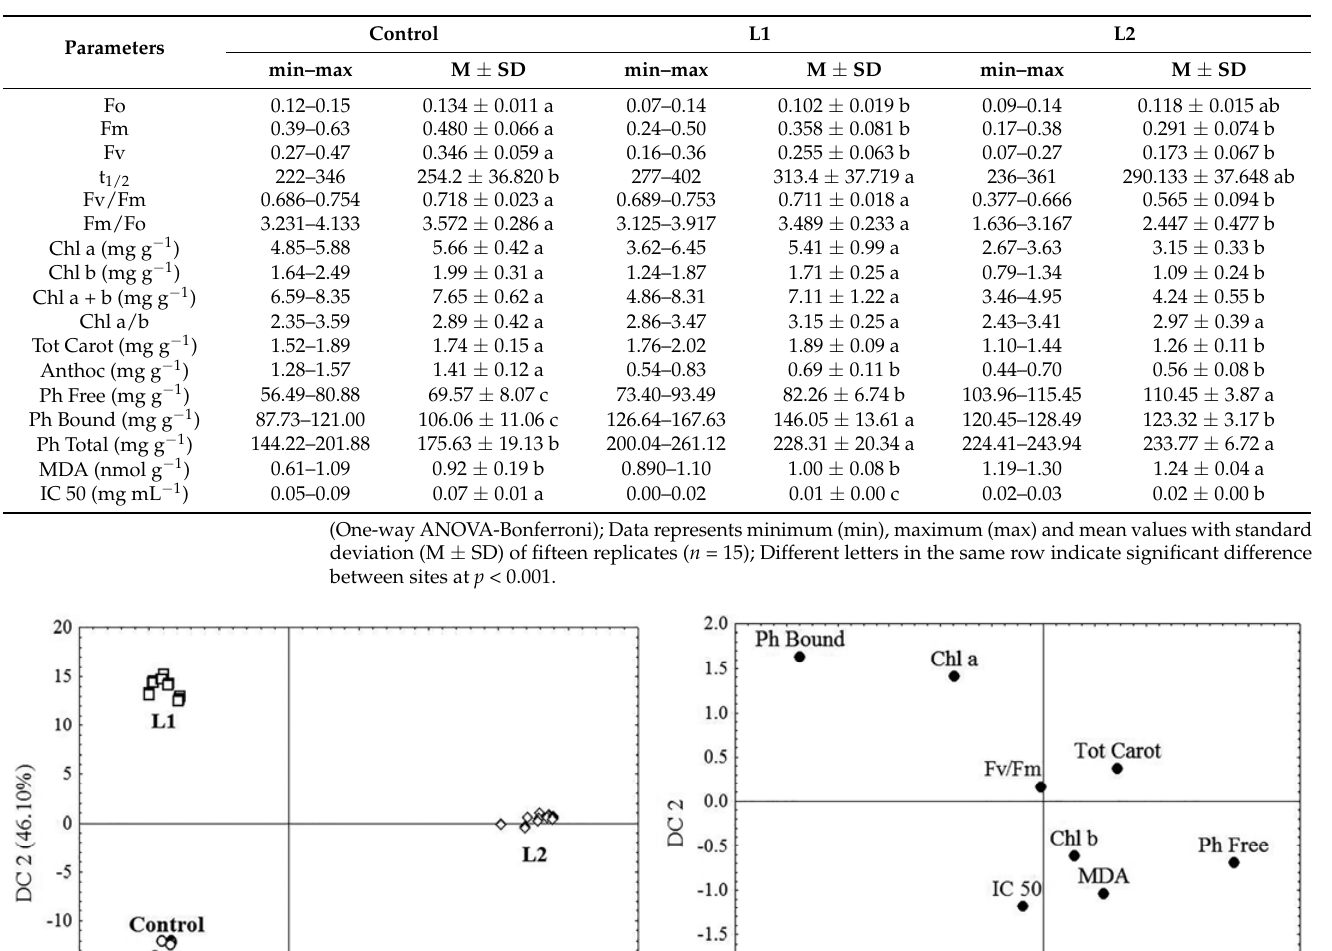
Table 4. The physiological and biochemical response of the leaves of T. tetrandra on fly ash (L1 and L2) and soil (Control).